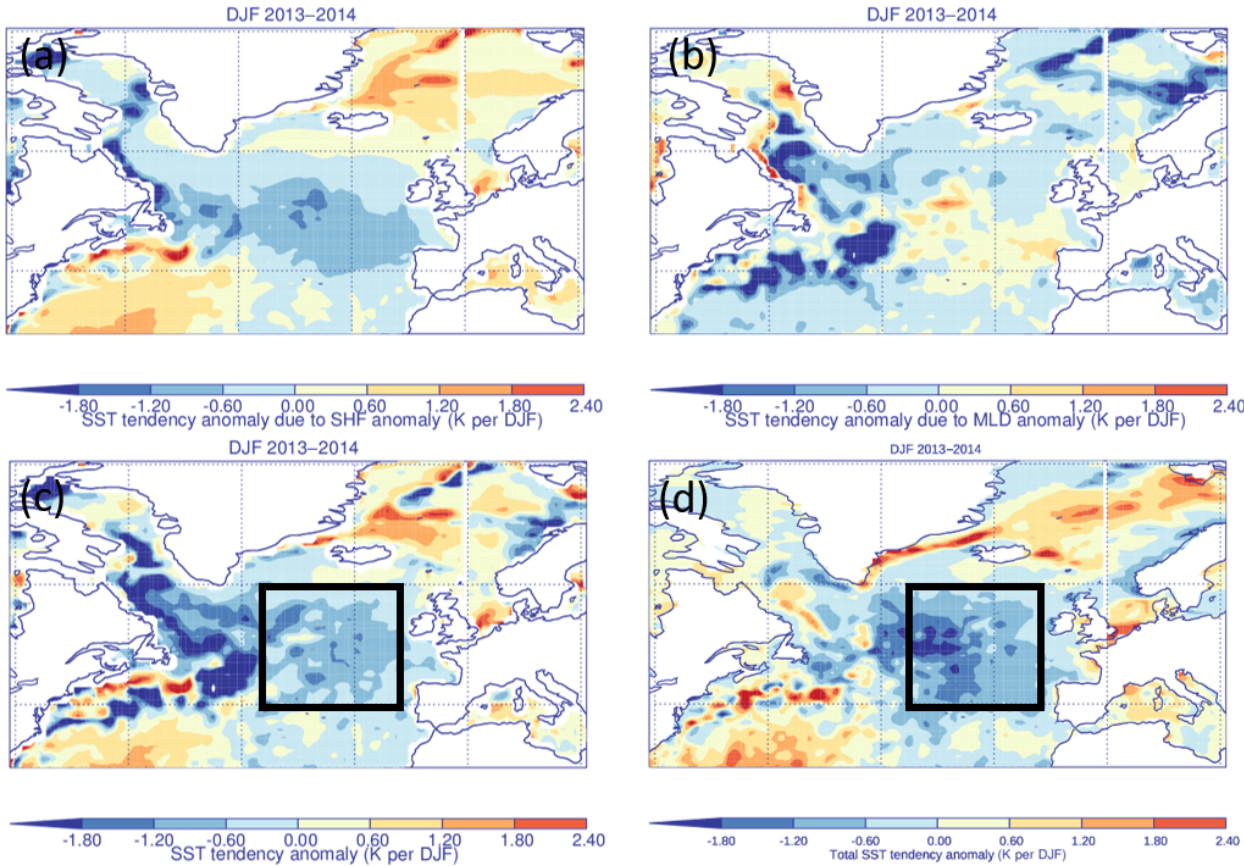
Figure 11. Anomalous (cid:49) SST due to 2013–2014 (a) Q N (SHF) anomaly, (b) MLD anomaly and (c) (cid:49) SST ASI anomaly. (d) (cid:49) SST TOT